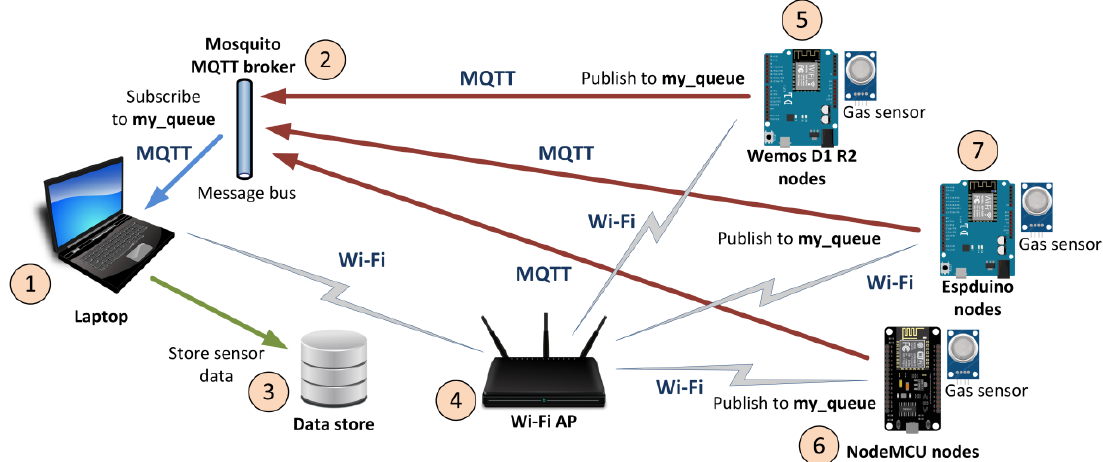
Figure 7. Deployment and connectivity of the testing platform